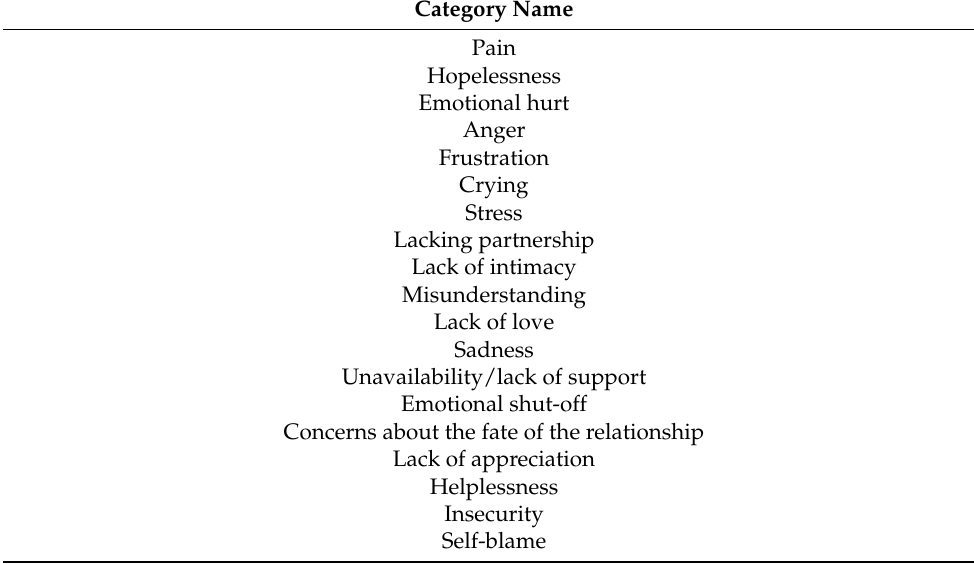
Table 2. Categories derived from content analysis of the semi-structured questionnaires, relevant scales and clinical